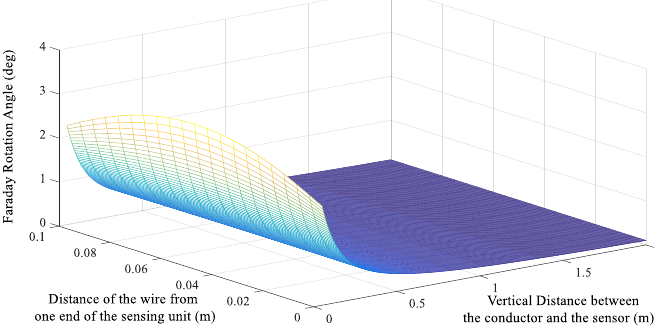
Figure 5. Faraday rotation angles in different relative positions.